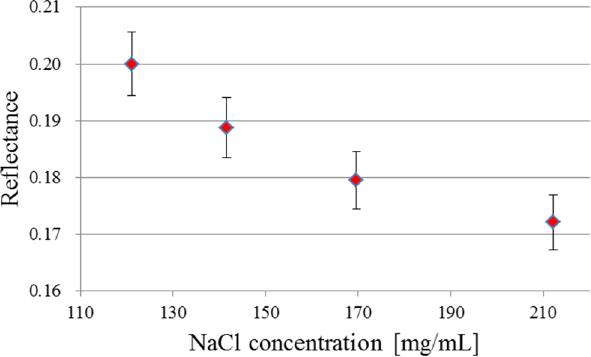
Figure 3. NaCl concentration dependence of amplitude of reflection spectra obtained at 0.86 THz.